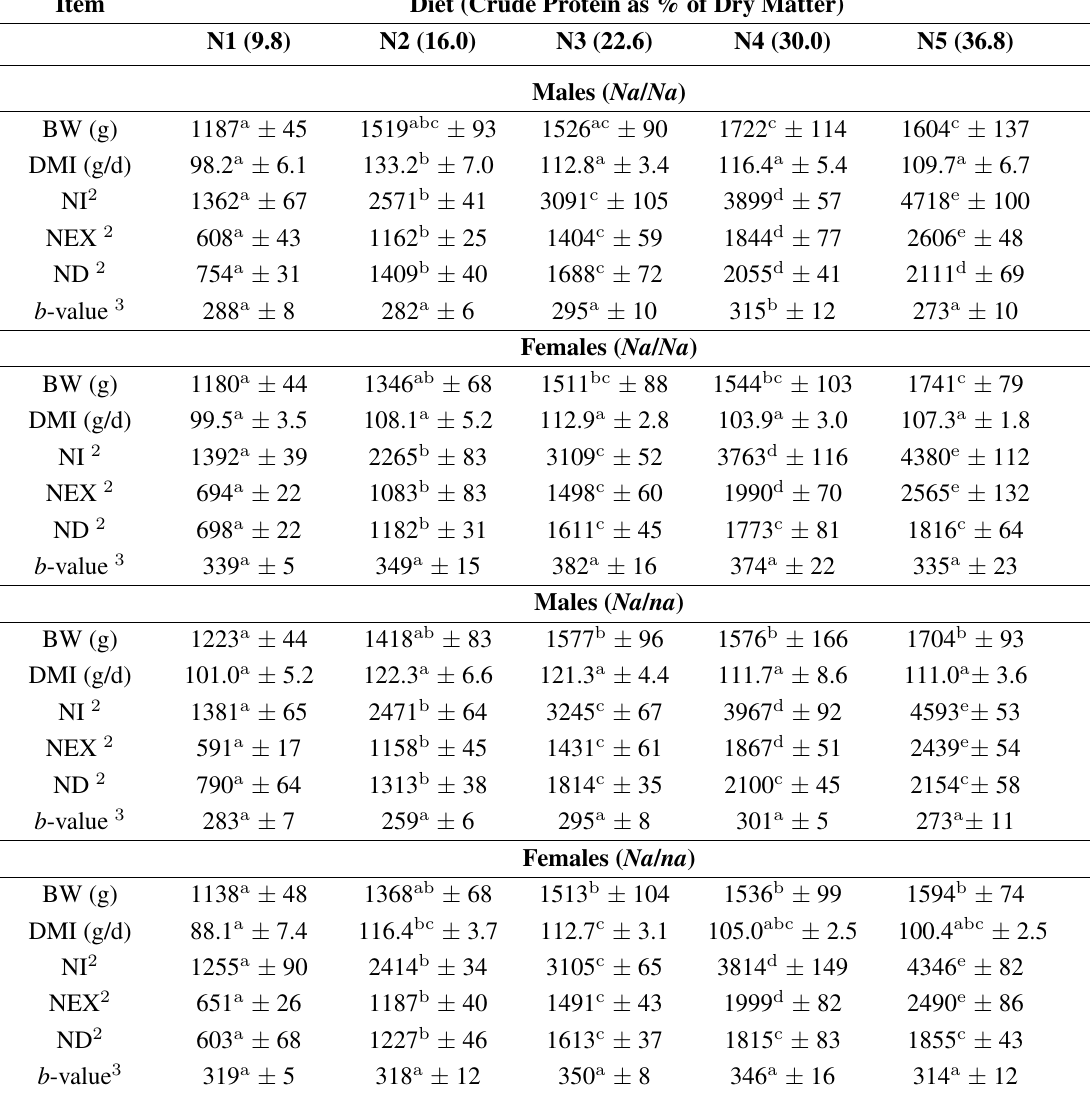
Table 5. Results of N balance experiments depending on dietary protein content, genotype and sex during grower period (days 25–35) 1